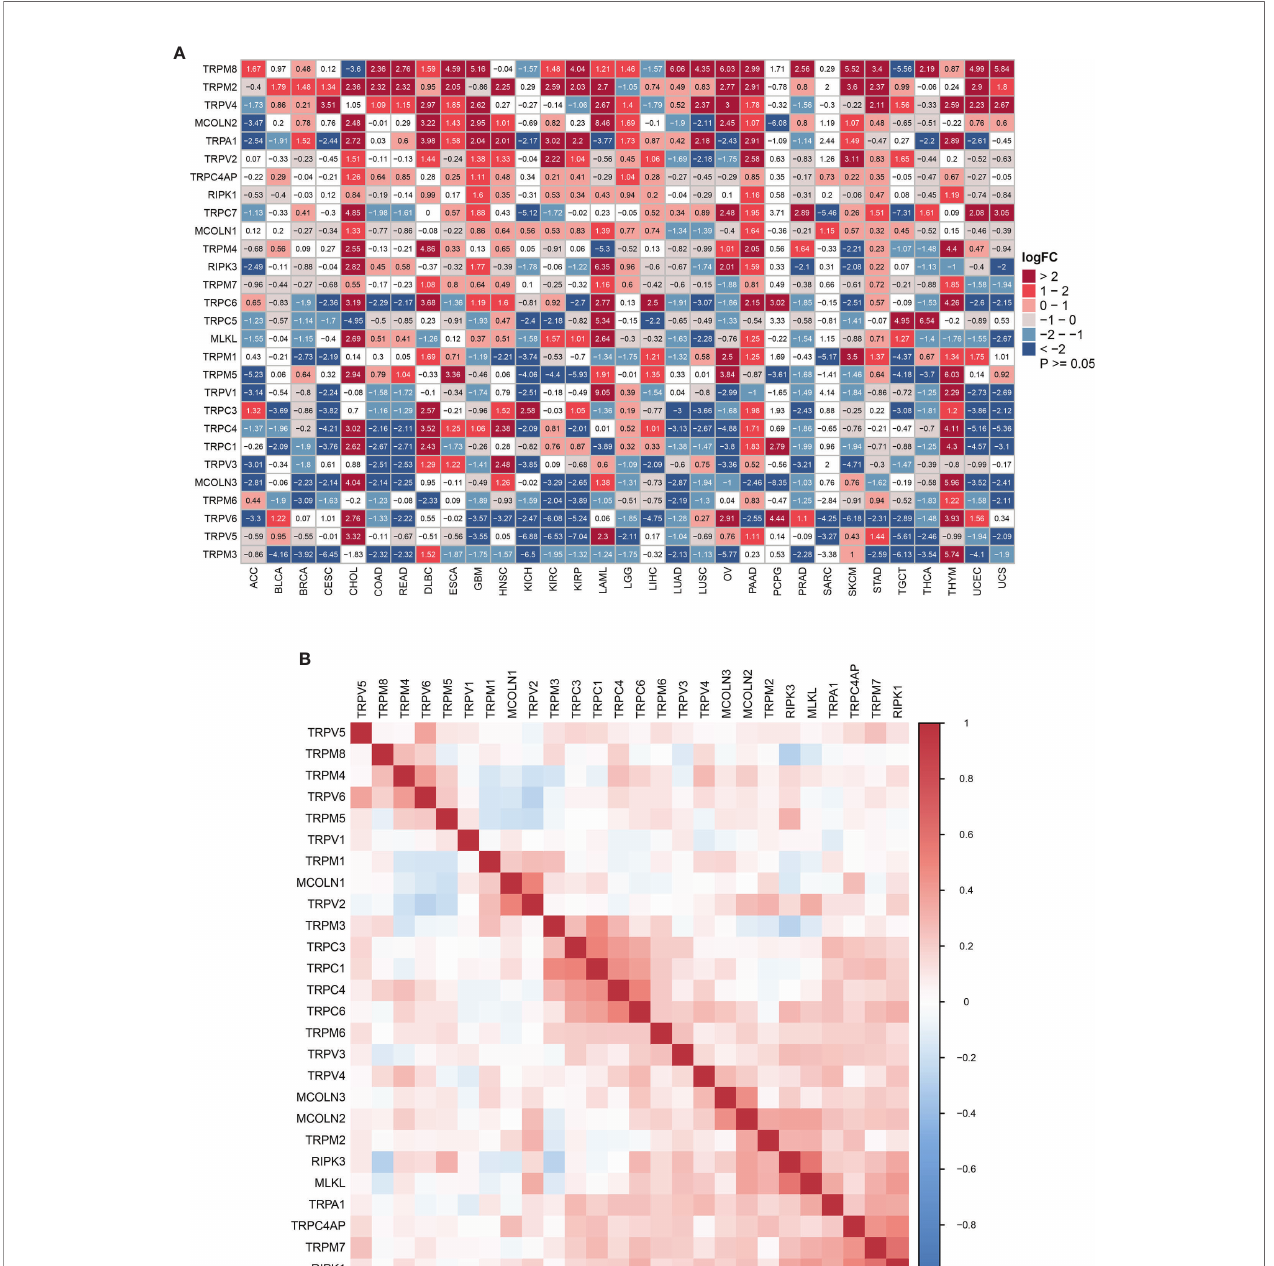
FIGURE 1 | The expression of TRP family genes. (A) The differential expression of the TRP family in 33 tumour types based on TCGA and GTEx cohorts. The logFC and P -value information is presented. (B) The correlation between TRP family genes based on TCGA pan-cancer data. The darker the colour, the stronger the